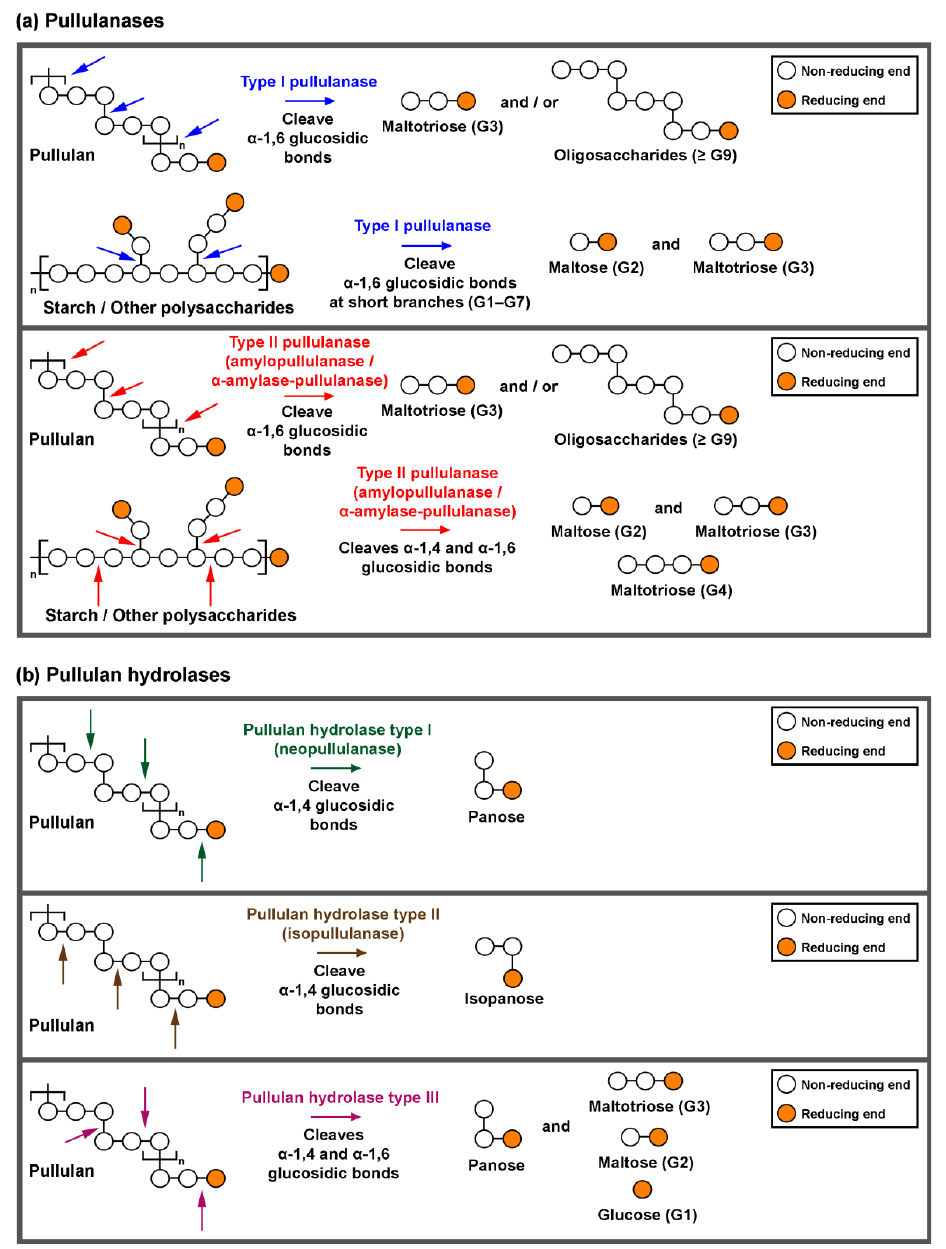
Figure 3. The action pattern of ( a ) pullulanases (types I and II) on pullulan, starch or other polysaccharides and ( b ) pullulan hydrolases (types I, II and III) on pullulan. Type II pullulanase (EC 3.2.1.1/41) can be divided into two subgroups: (i)